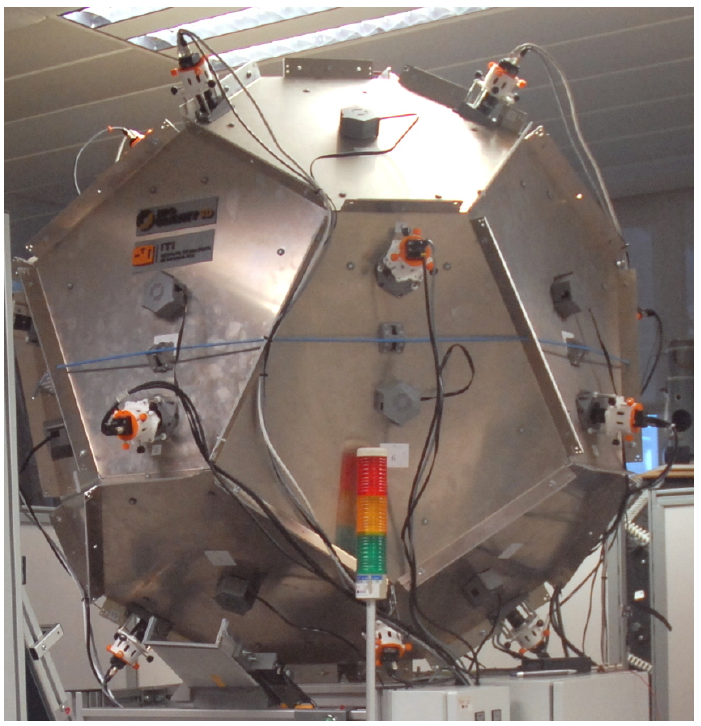
Figure 1. Industrial inspection system Zero Gravity 3D